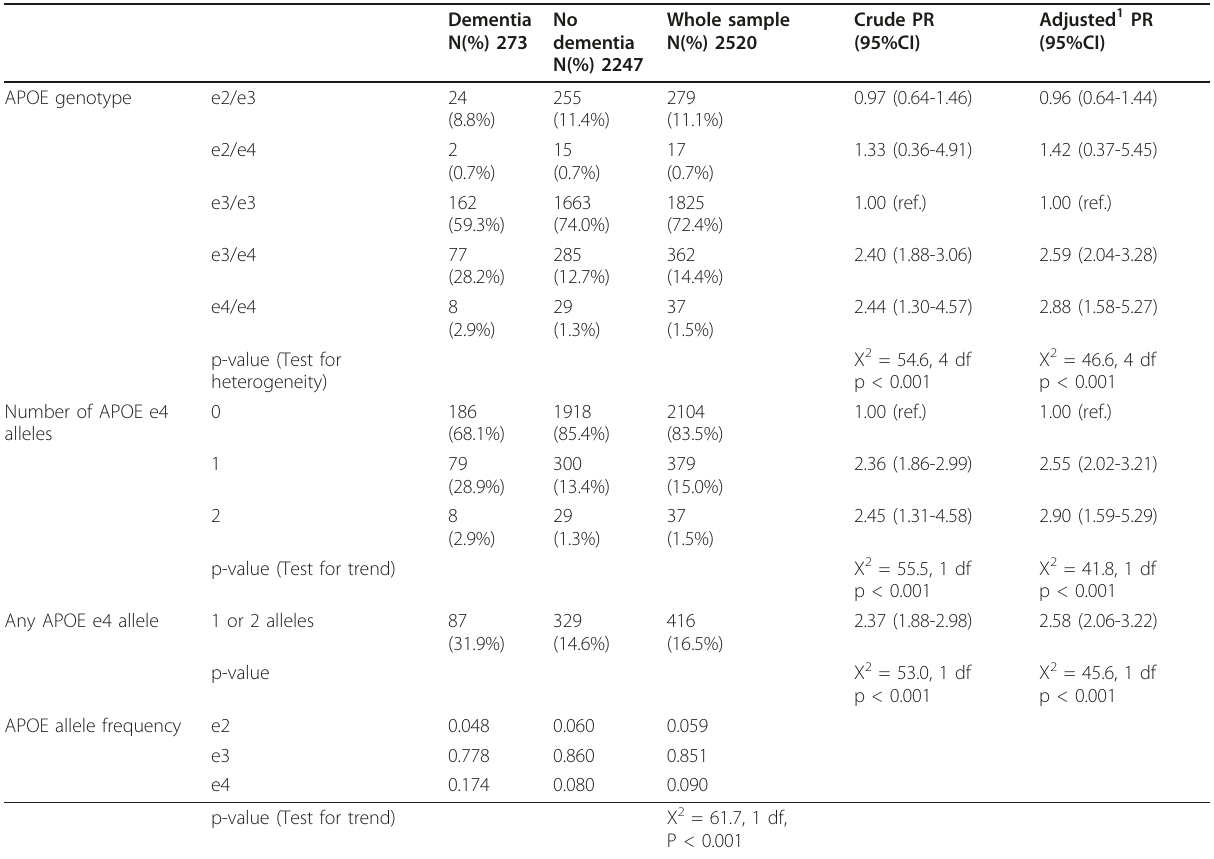
Table 3 APOE Genotype and APOE allele frequency by dementia status, with crude and adjusted prevalence ratios and 95% confidence